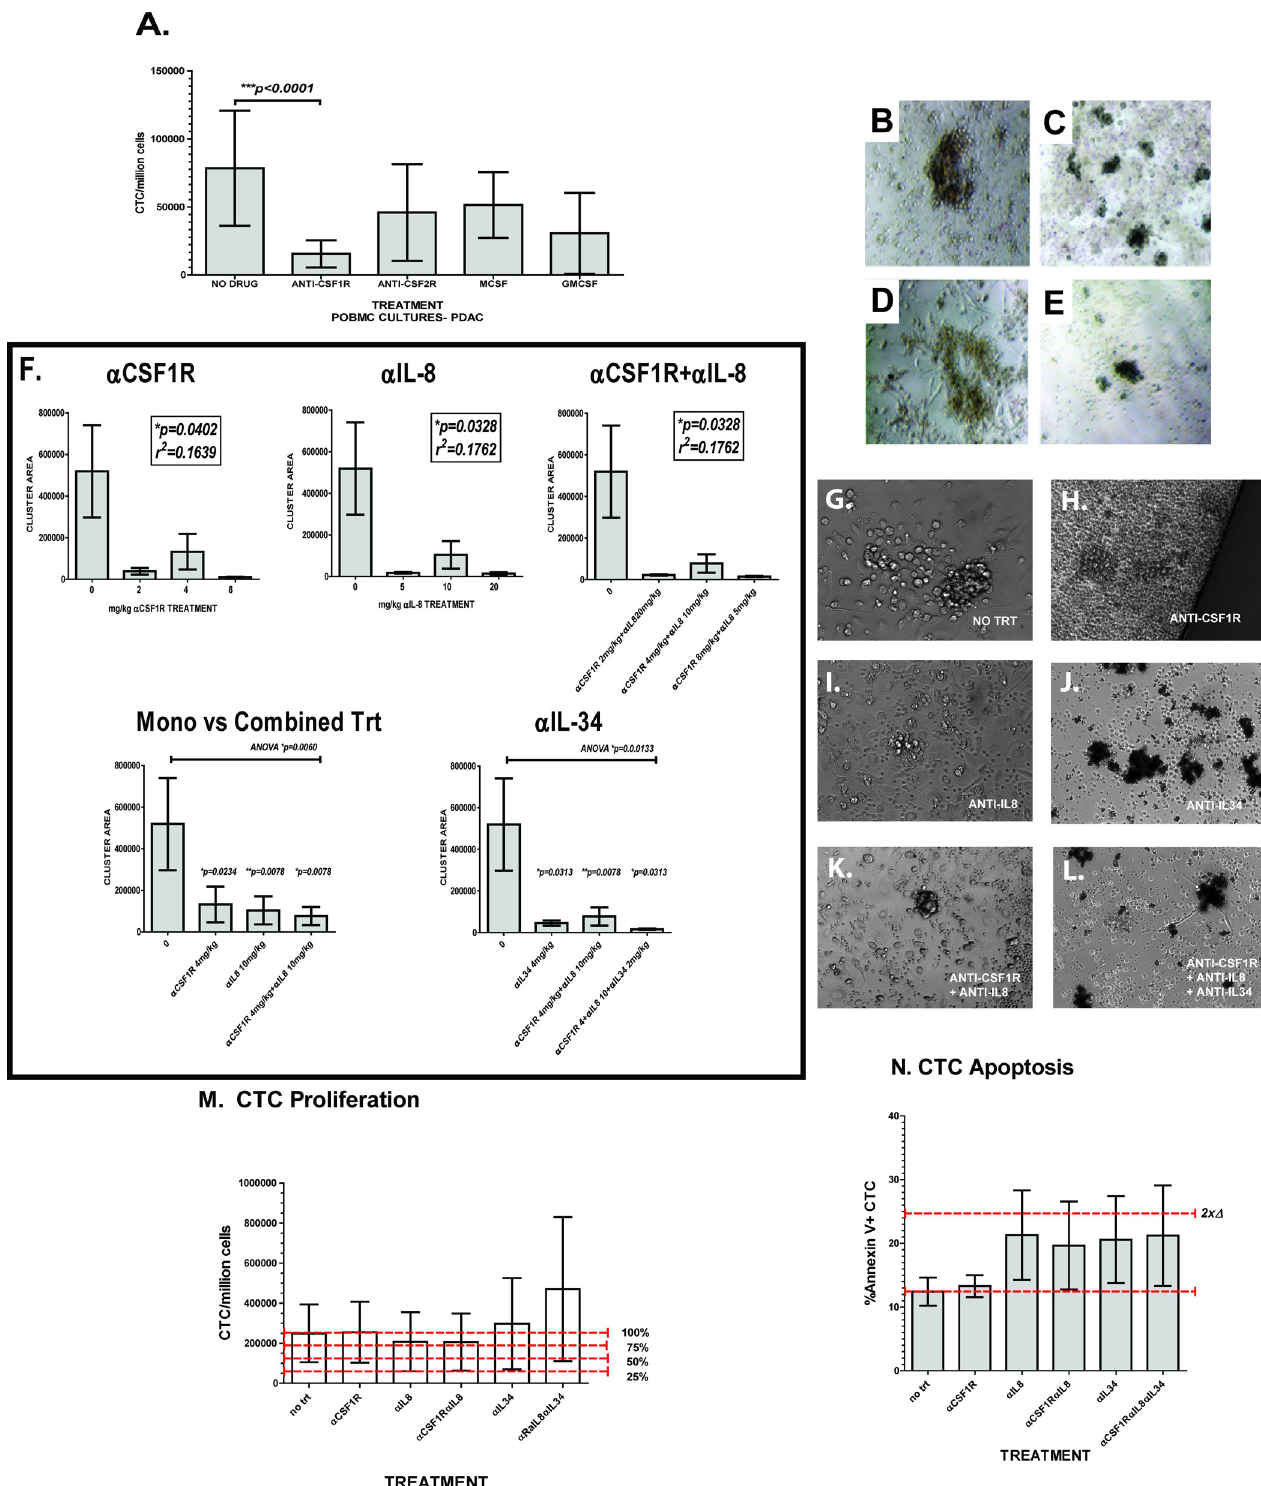
Fig 3. CSF1R and IL-8 mediated signaling affect PDAC portal blood CTC proliferation, cluster formation, and apoptosis. Sixteen PDAC patient PortalBMC unsorted samples were grown in ex vivo culture for 7 days with or without 1 μ g/million PortalBMC rabbit anti-CSF1R antibodies, 1 μ g/million PortalBMC mouse anti-CSF2R antibodies, 0.5 μ g/ml M-CSF or 5nM GM-CSF. ( A ) Addition of GM-CSF, M-CSF, or antibodies against the GM-CSF receptor ( ANTI-CSF2R ) to unsorted PortalBMC cultures did not significantly change mean CTC proliferation compared to untreated cultures ( NO DRUG ). Anti-